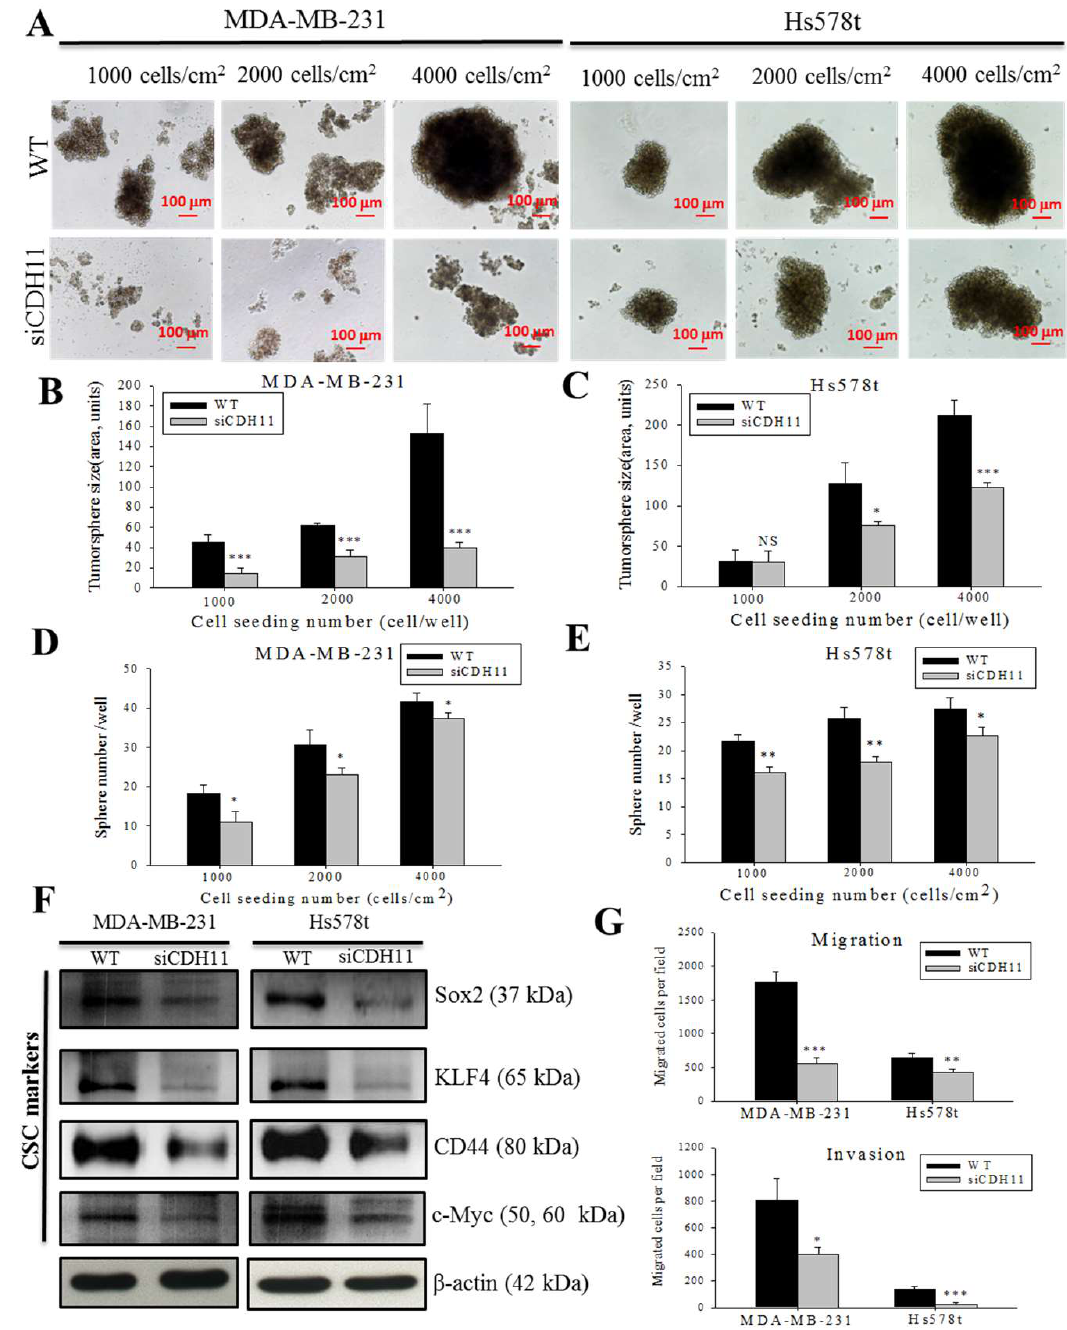
Figure 5. CDH11 inhibition suppresses the stem cell-like phenotype of TNBC cells. ( A ) Images showing tumorsphere size in wild-type cells and their siCDH11 counterparts of varying cell density. Histograms comparing the tumorsphere sizes of wild-type or si-CDH11 ( B ) MDA-MB-231 and ( C ) Hs578t. Histograms comparing the number of tumorspheres formed by wild-type or si-CDH11 ( D ) MDA-MB-231 and ( E ) Hs578t cells, based on ImageJ quantification. Only tumor spheres ≥ 40 µ m in size were counted. ( F ) The effect of siCDH11 on the expression Sox2, KLF4, CD44, and c-Myc proteins in MDA-MB-231 and Hs578t cells. ( G ) Graphical representation of the migration ( upper panel) and invasion (lower panel) of MDA-MB-231 and Hs578t cells. Results represent mean ± SD of 3 independent assays in triplicate. * p < 0.05, ** p < 0.01, *** p < 0.001; WT, wild type; NS, not significant; Scale bar: 100 µm.